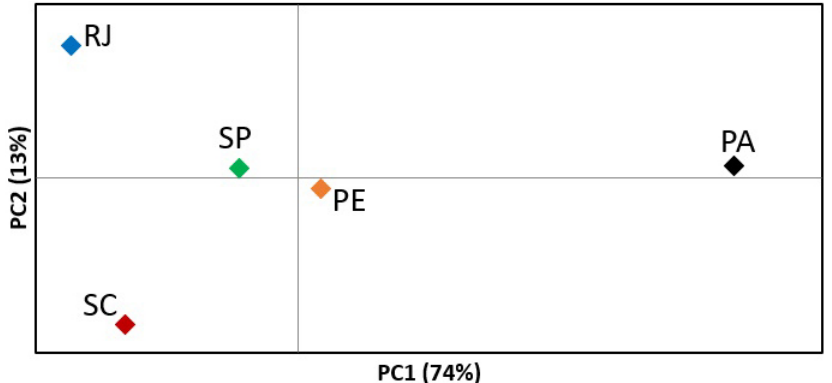
FIGURE 2 | Principal component analysis (PCA) analysis based on Nei distances using five Rhinoptera bonasus microsatellite markers. Collection areas: Santa Catarina (SC, red), São Paulo (SP, green), Rio de Janeiro (RJ, blue), Pernambuco (PE, orange) and Pará (PA, black).